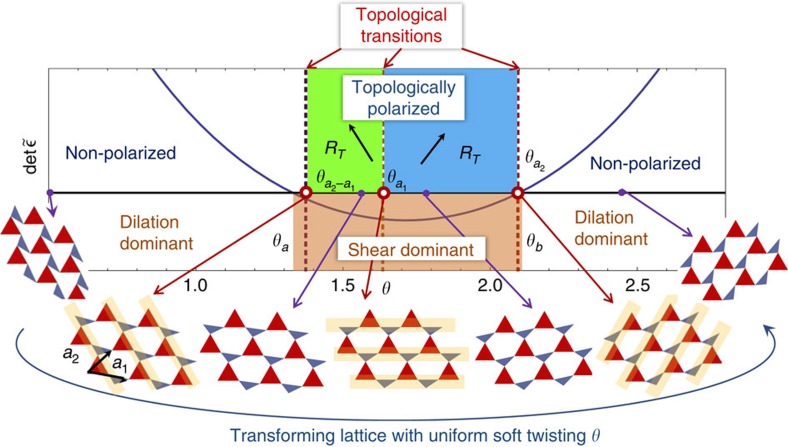
Topological transitions of a deformed kagome lattice by uniform soft twisting.Two types of triangles (red and blue) are connected by free hinges at their corners, forming a deformed kagome lattice with primitive vectors a1, a2. The angle θ between the triangles defines the twisting coordinate. The blue curve shows  (defined in equation (1)) as a function of θ. The 3 white dots on the θ axis represent three critical angles (,  and ) where sides of the triangles form straight lines (yellow stripes on the lattices) and topological polarization RT (shown as black arrows above the axes) changes.